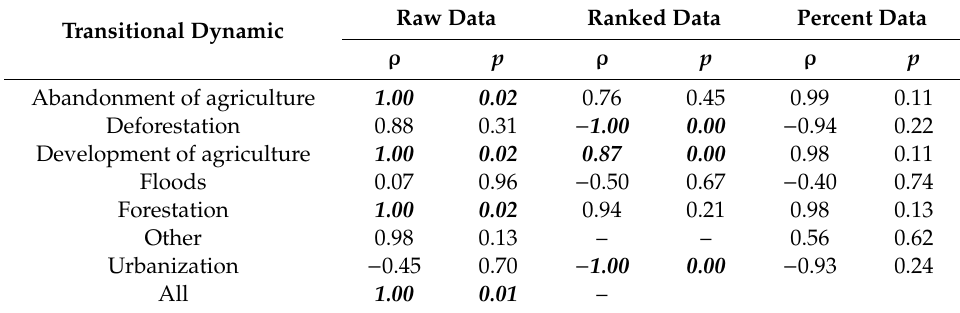
Table 1. Trends of the di ff erent transitional dynamics associated to land cover and use changes in Romania during 1990–2012, using CORINE data. The table contains the values of Bravais–Pearson coe ffi cient of linear correlation ( ρ ) and its associated p-value. Bold Italic values are significant at α = 0.05. Negative ρ values indicate an increasing trend.